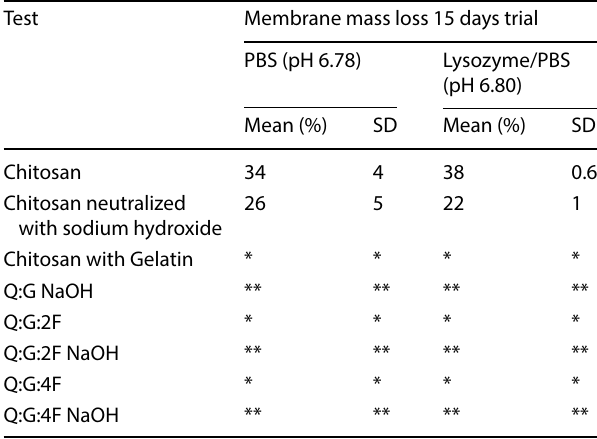
Table 1 Percentage mass loss membranes subjected to biodegra- dation tests and their standard deviations